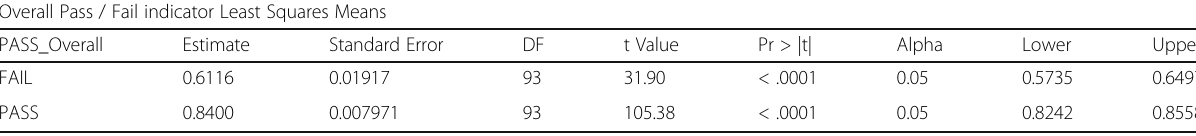
Table 4 Mean score estimation for each variable: There are statistical differences between FAIL and PASS groups, but not between competences Overall Pass / Fail indicator Least Squares Means PASS_Overall